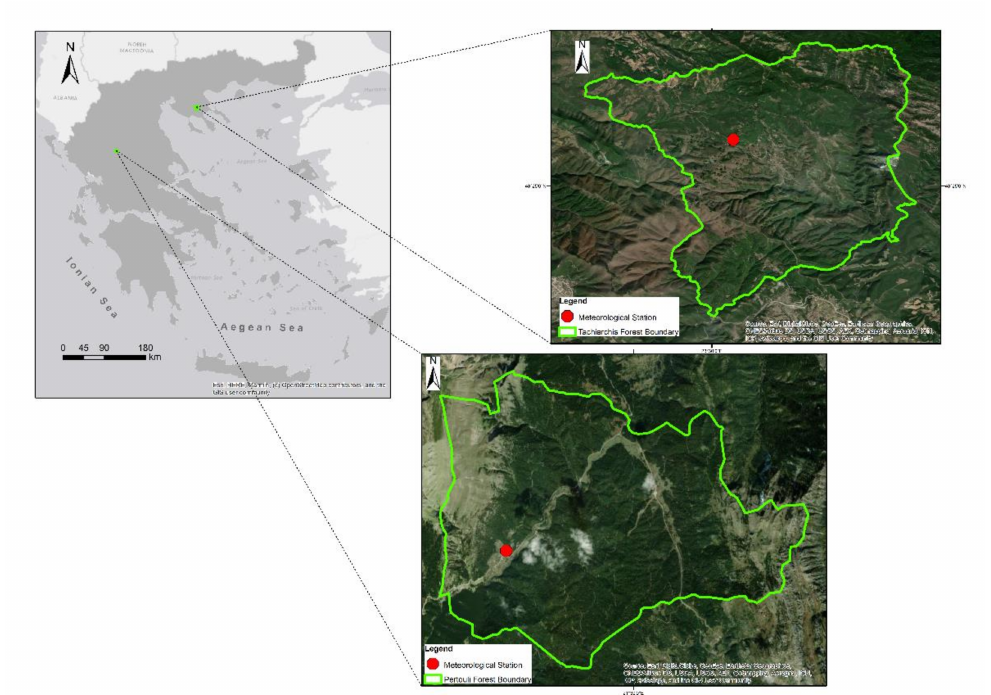
Figure 1. Location map of the selected forest ecosystems. The Pertouli University Forest is located in the mountainous range of Pindus (Trikala Prefecture, Central Greece) and covers an area of 3290 ha. It consists mainly of pure fir stands ( Abies borisii regis ) and the elevation ranges between 1100 and 2073 m above sea level (a.s.l). The climate is transitional, Mediterranean–Mid–European, with cold, rainy winters and warm, dry summers. The average annual precipitation is 1542.2 mm and the average mean annual air temperature is 8.9 ◦ C according to the existing meteorological station (1180 m a.s.l), which has operated since 1961 and is located at latitude 39 ◦ 32 (cid:48) 35.8 (cid:48)(cid:48) and longitude 21 ◦ 28 (cid:48) 8.5 (cid:48)(cid:48) . Specifically, the total precipitation was found to be 525.7 mm in winter, 432.6 mm in autumn, 337.9 mm in spring, and 128.1 mm in summer. The average air temperature was found to be 0.8 ◦ C in winter, 9.9 ◦ C in autumn, 7.7 ◦ C in spring,